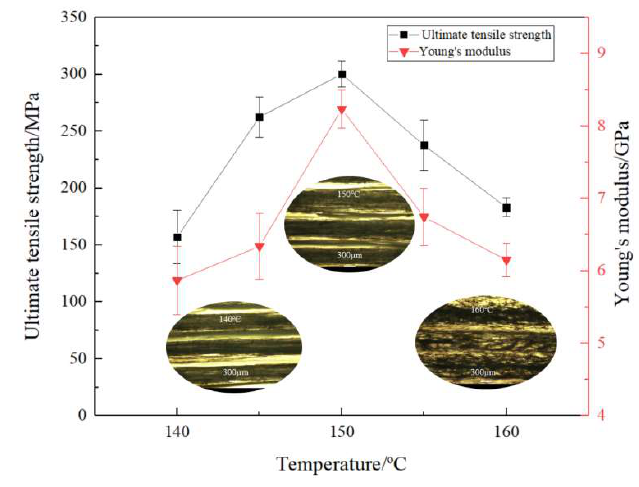
Figure 4. Mechanical properties of the CFSRCs printed at various temperatures.